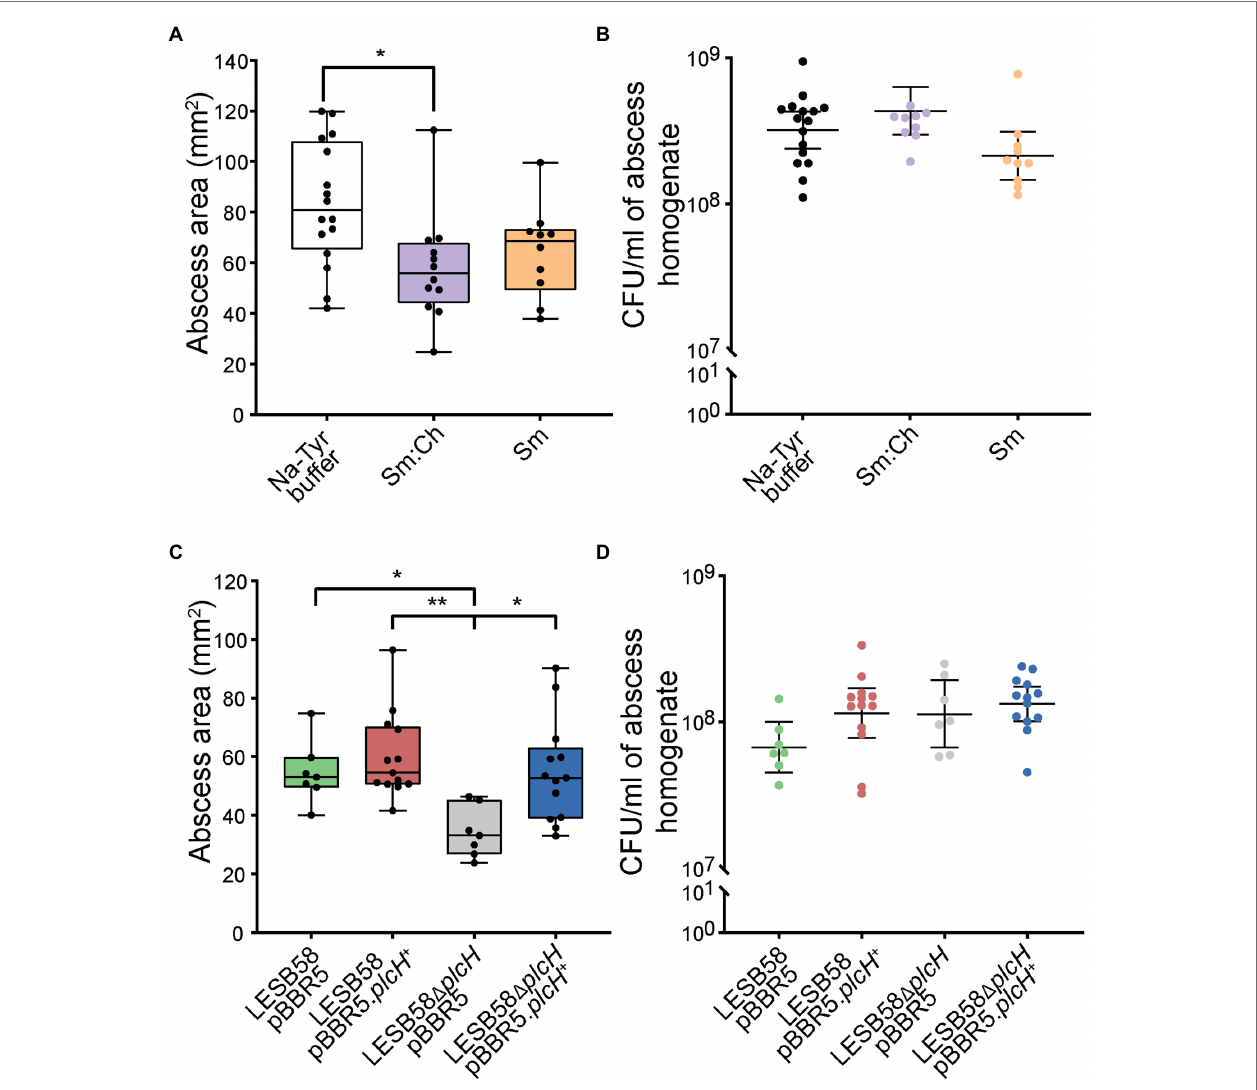
FIGURE 3 | Effects of liposome treatment and phospholipase knockout mutant in a Pseudomonas aeruginosa LESB skin abscess mouse model. CD-1 mice were subcutaneously infected with a high bacterial density (5 × 10 7 CFU) of LESB58 wild type (A,B) , LESB58 carrying an empty vector pBBR5 or overexpression vector pBBR5. plcH + , and phospholipid mutant LESB58. Δ plcH carrying an empty vector pBBR5 or overexpression vector pBBR5. plcH + (C,D) . Lesion sizes (Box and whiskers plot) and CFU counts (with geometric mean) were determined 3 day post-infection. Liposome treatment (top) and mutant studies (bottom)— (A,C) abscess size measurements, and (B,D) bacterial counts per abscess. All experiments were done at least three times independently with 2–4 mice/group. Statistical analysis was performed using one-way ANOVA, Kruskal-Wallis test with Dunn’s correction. The asterisk indicates a significant difference to the wild type (* p < 0.05; ** p <